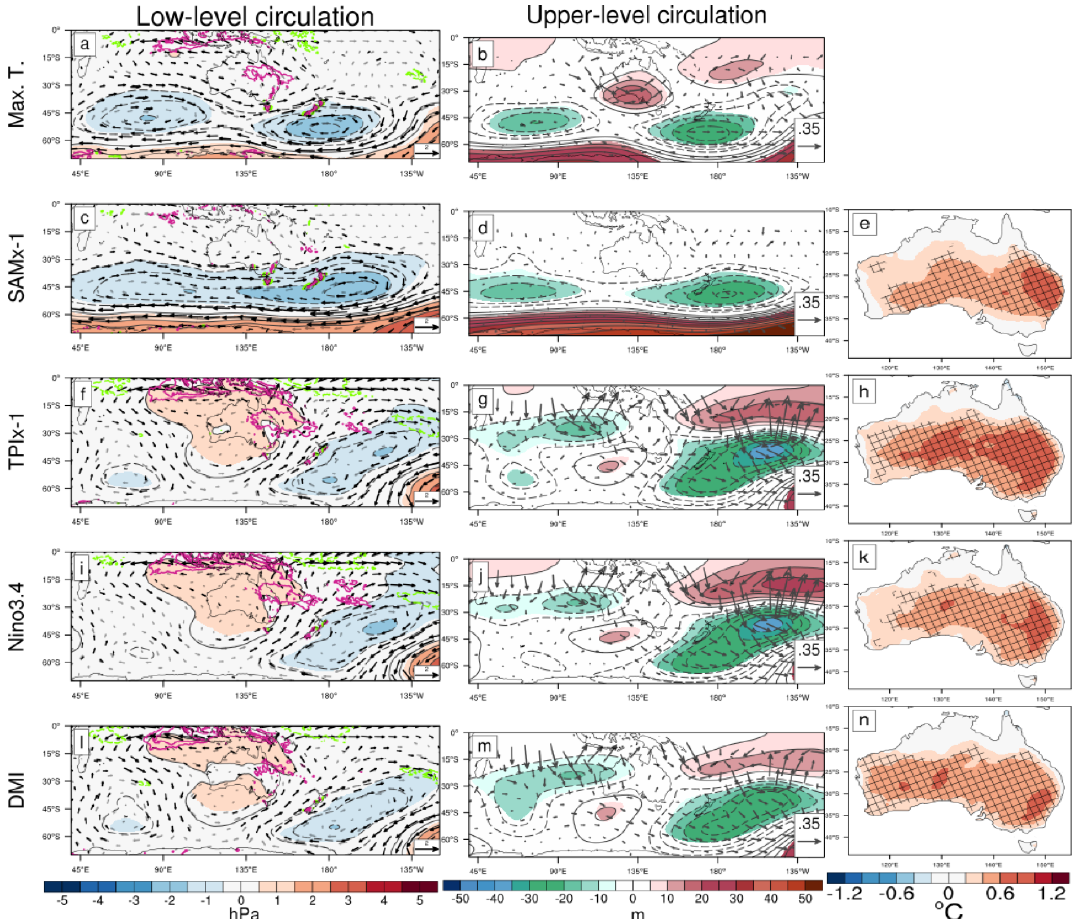
Figure 1. Linear regressions of spring standardised weighted area-averaged Australian maximum temperature (a–b) , SAMx-1 (c–e) , tropical TPIx-1 (f–h) , Niño3.4 (i–j) , and DMI (j–n) onto low-level circulation (left column) and upper-level circulation (middle column) and Aus- tralian maximum temperatures (right column). Low-level circulation is represented by anomalous mean sea level pressure (hPa) (black and filled contours), 850hPa wind vectors (ms − 1 ) , and 500hPa omega (hPas − 1 ) contours from − 0 . 02 to 0.02hPas − 1 in steps of 0.01hPas − 1 (magenta contours are positive ( downward motion), and cyan contours are negative (upward motion), and the zero contour is not plotted). Upper-level circulation is represented by 200hPa geopotential height (black and filled contours and wave activity flux vectors (m 2 s − 2 ) ). Filled contours, bold wind vectors, cross-hatching, and all vertical motion contours are significant at the 95% confidence level using Student’s t test with 39 independent